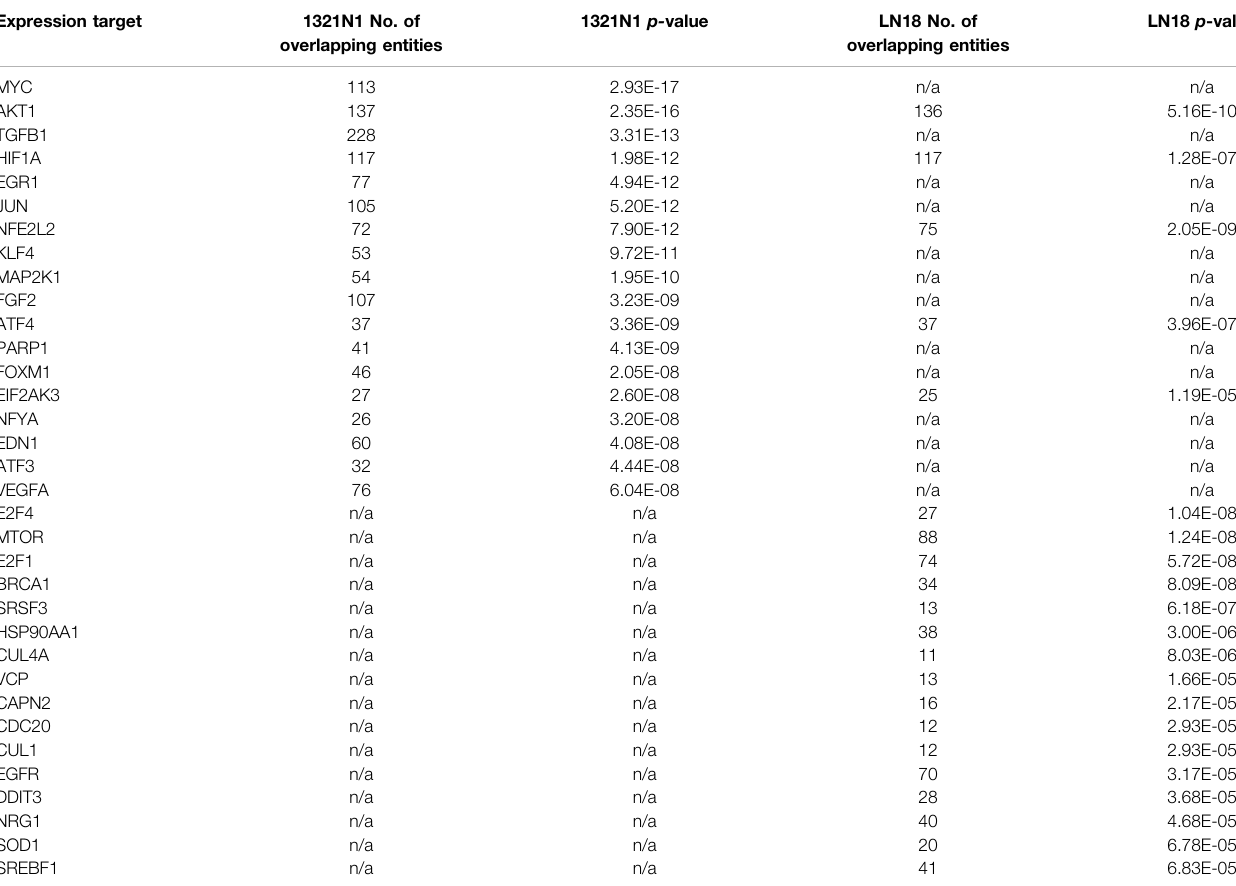
TABLE 5 | Subnetwork enrichment analysis on gene dataset of p < 0.05, FDR. Expression target 1321N1 No. of 1321N1 p- value LN18 No. of overlapping entities overlapping entities MYC